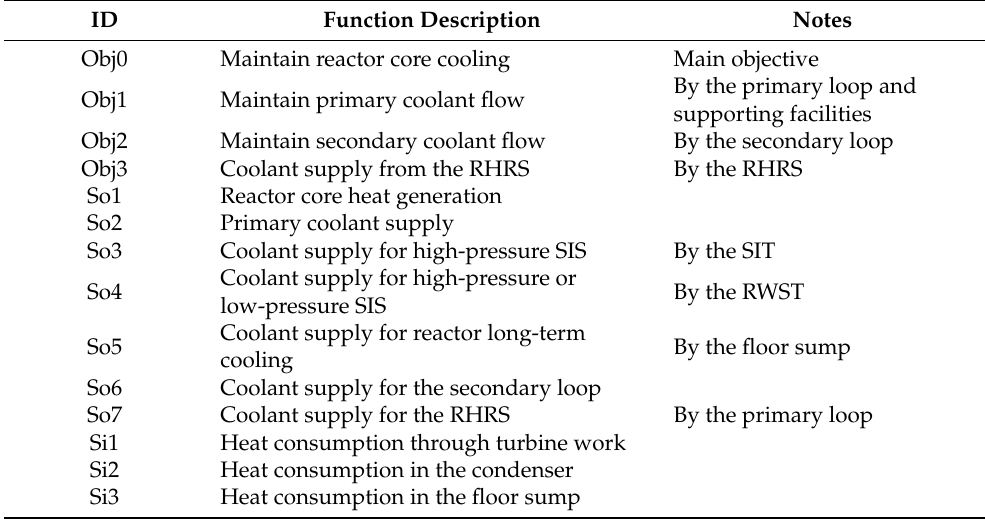
Table 2. The explanation of the main MFM elements in Figure